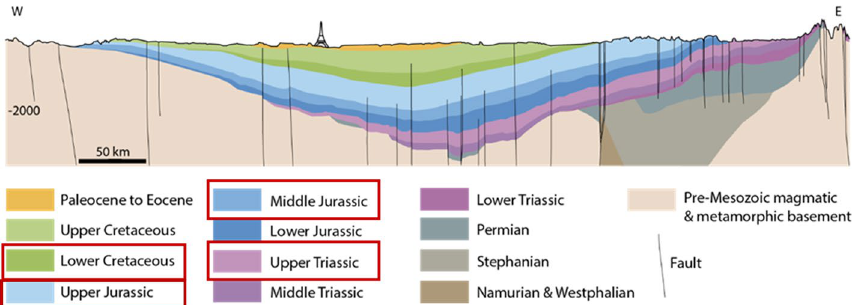
Fig. 4 Main geological units for geothermal application in the Paris